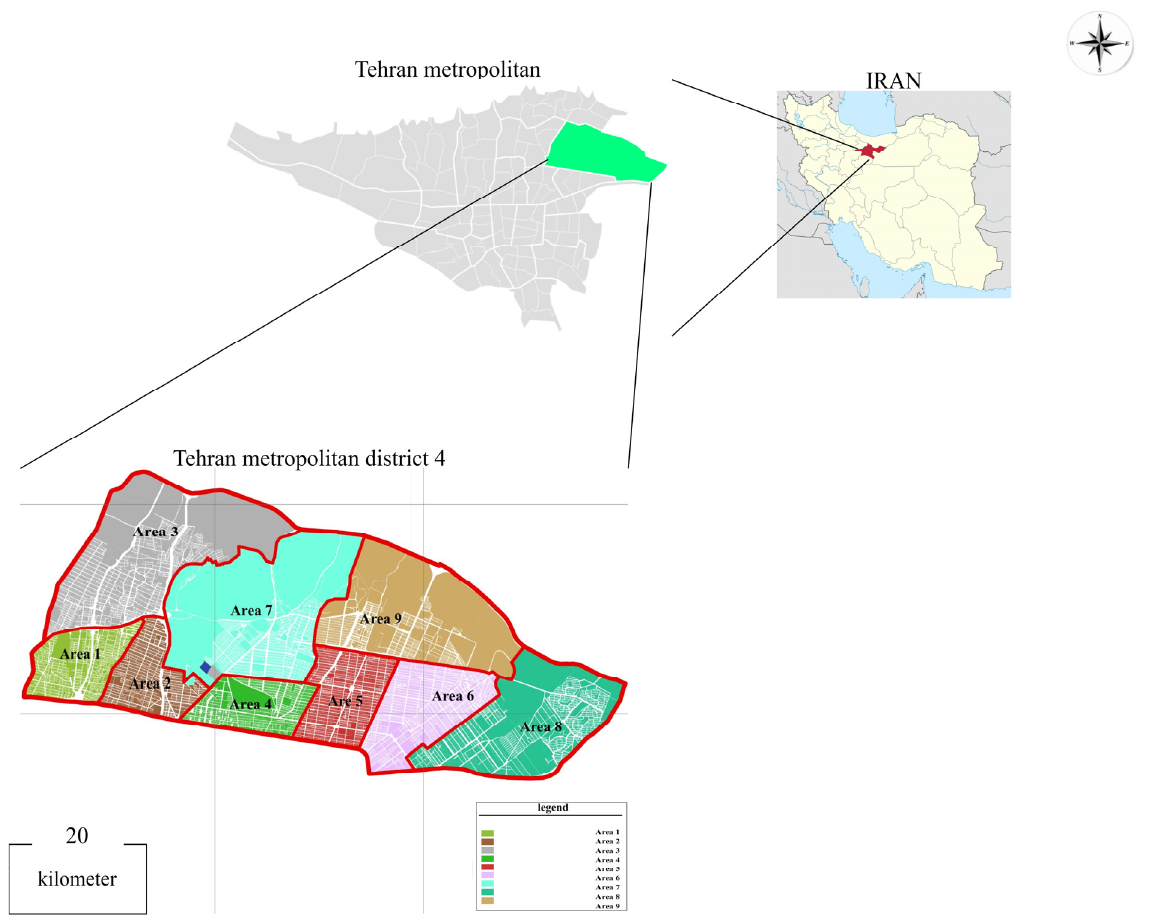
Figure 1. Study area. Table 1. Specifications of the 9 regions of District 4. Table 1. Specifications of the 9 regions of District